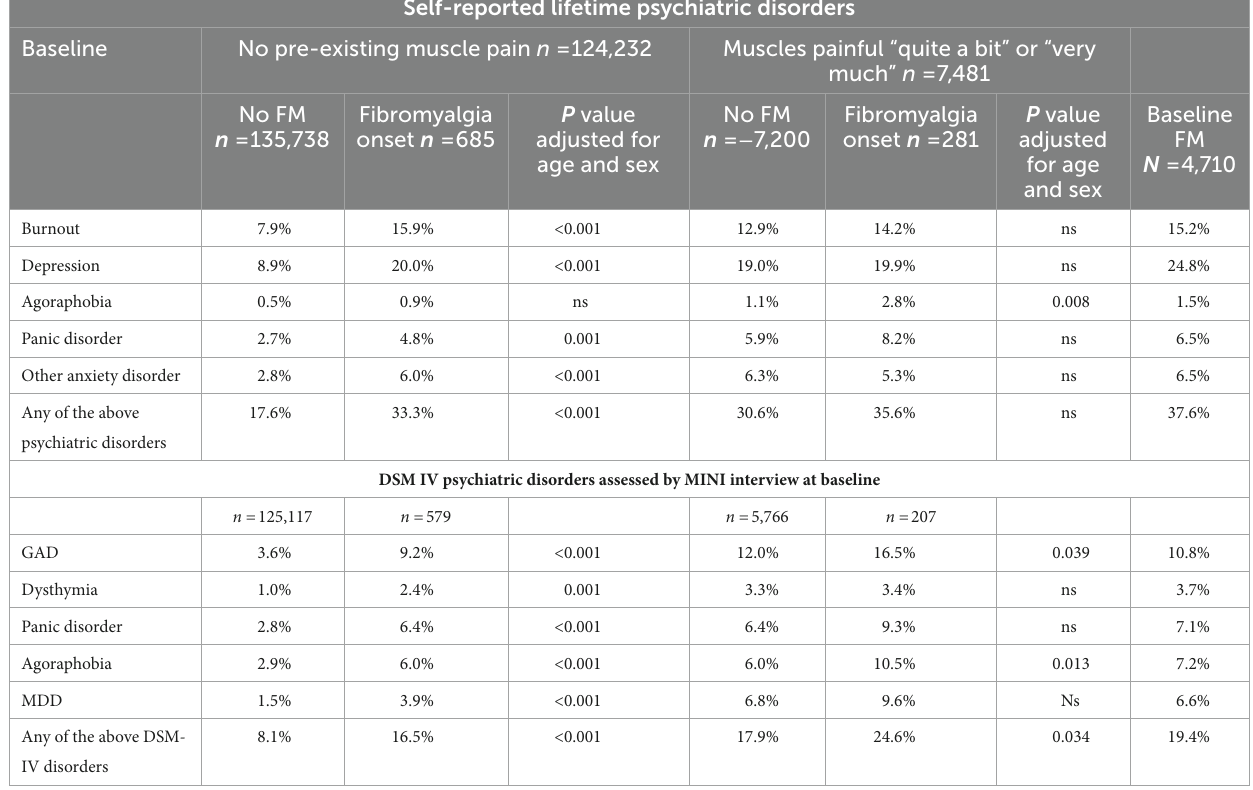
TABLE 3 Psychiatric disorders and self-rated fibromyalgia onset by baseline muscle